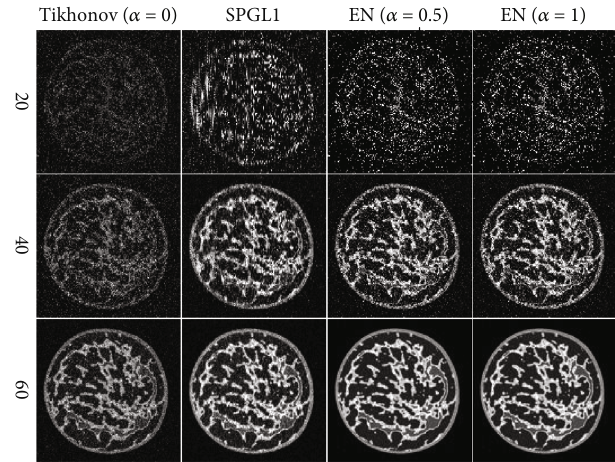
Figure 2: The breast phantom reconstruction results by di ff erent methods. The fi rst to the third rows are the reconstruction results of 20, 40, and 60 views evenly distributed on the circumference, respectively. The fi rst to fourth columns display results of the Tikhonov ( α = 0 ), SPGL1, EN ( α = 0 : 5 ), and EN ( α = 1 )